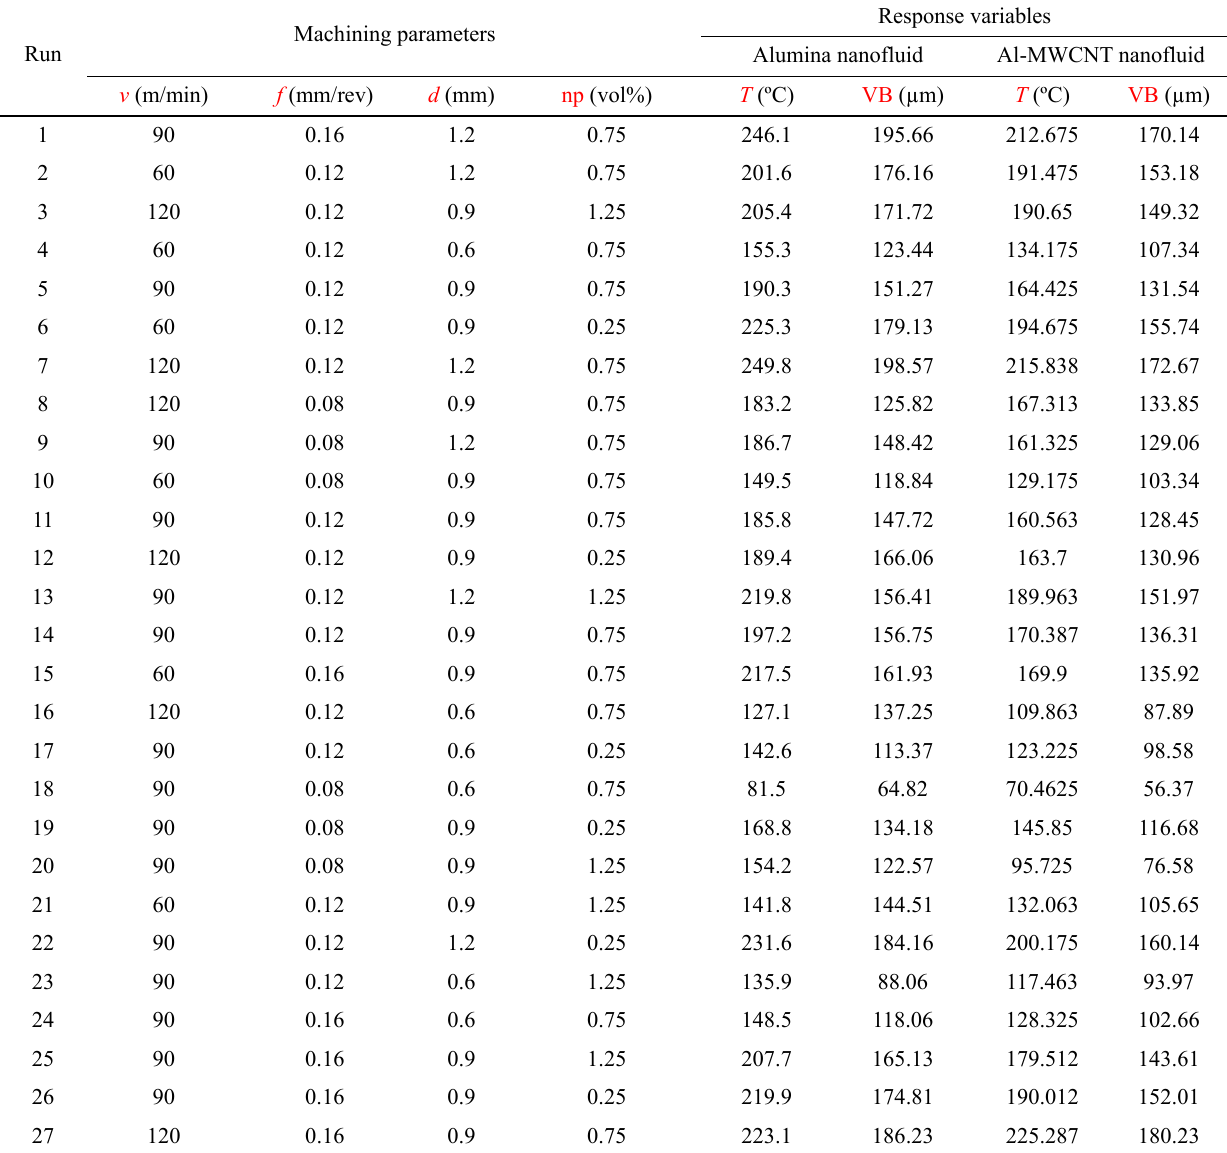
Table 2 Experimental results for T and VB using Alumina (Al 2 O 3 ) and Al-MWCNT hybrid